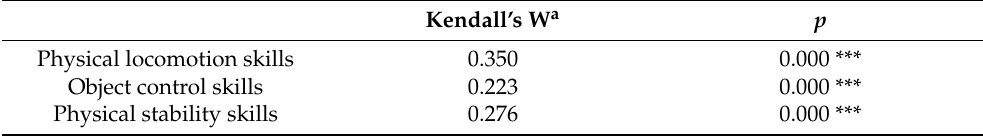
Table 3. The results of the expert questionnaire.